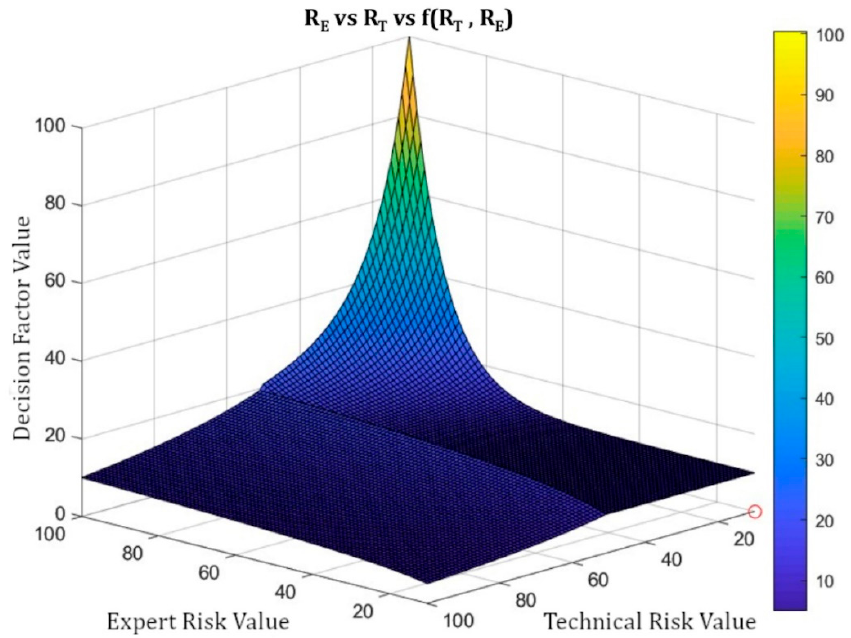
Figure 9. Fundamental curves: Expert Risk vs. Decision Factor for different Technical Risk values.